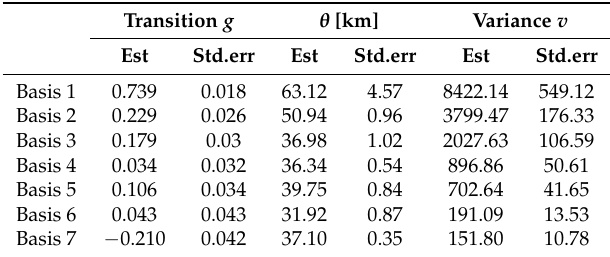
Table 5. Estimates and standard error of parameter g , θ , and v .